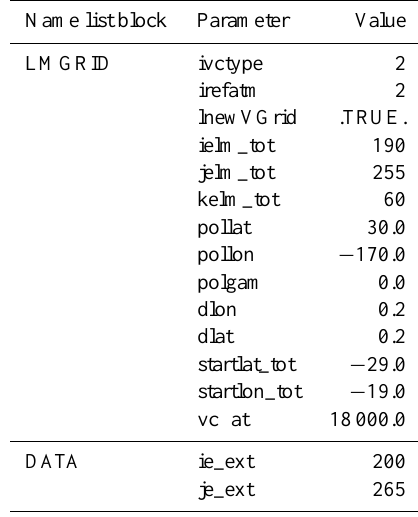
Table A2. Name list parameters of the preprocessor int2lm needed to reproduce the model